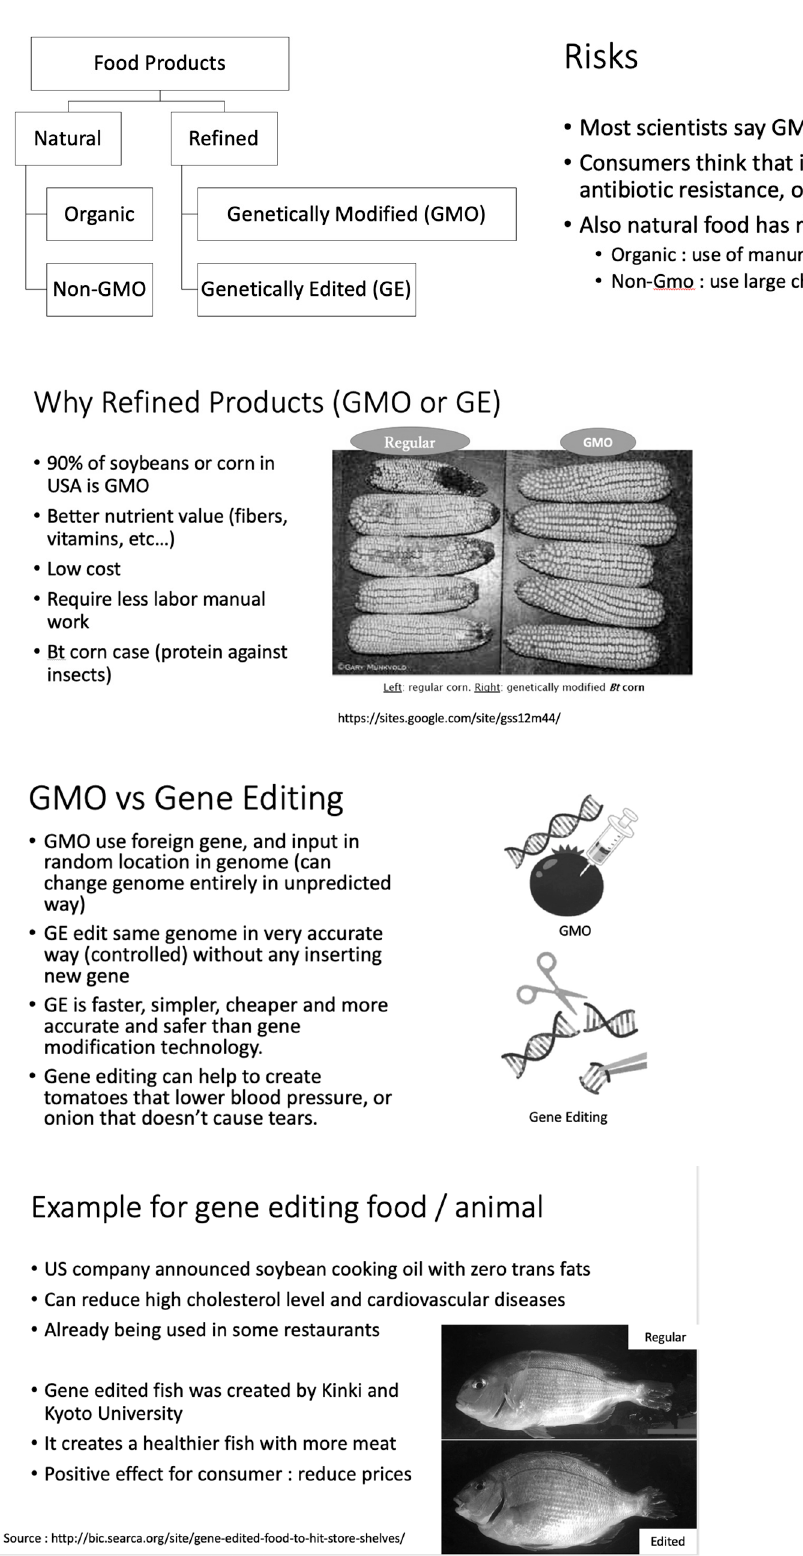
Figure B1. Presentation slides used as an intervention between the first and second surveys. Figure A1. Presentation slides used as an intervention between the first and second